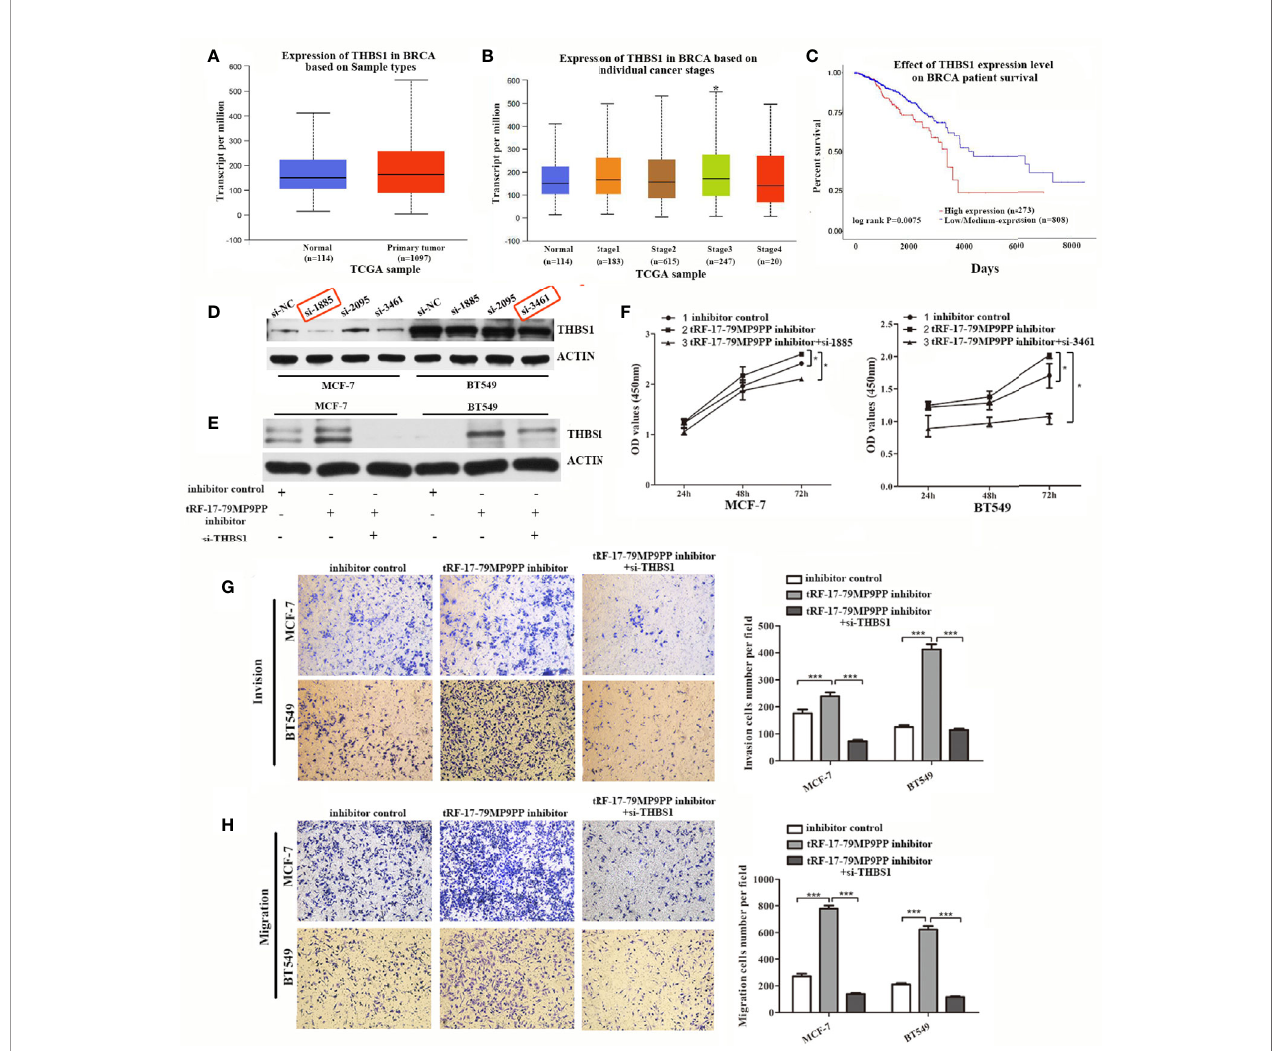
FIGURE 6 | Attenuation of THBS1 expression rescues the tRF-17-79MP9PP-mediated inhibitory effects on breast cancer cells. (A) The expression of THBS1 between cancer and normal samples in TCGA database. (B) Expression of THBS1 in breast cancer based on individual cancer stages in TCGA database. (C) Prognostic effect of THBS1 for breast cancer was displayed in TCGA database. (D) Protein levels in MCF-7 and BT549 cells transfected with THBS1 siRNA or siRNA negative control. (E) Western-blot analysis was used to detect THBS1 expression in cells transfected with tRF-17-79MP9PP inhibitor, si-THBS1 or negative control. (F) Cell viability of MCF-7 and BT549 cells after transfected with tRF-17-79MP9PP inhibitor, si-THBS1 or negative control was detected by CCK-8 assay. Cell Migration assays (G) and invasion assays (H) were performed in treated cells. * p < 0.05; *** p < 0.001 statistically signi fi